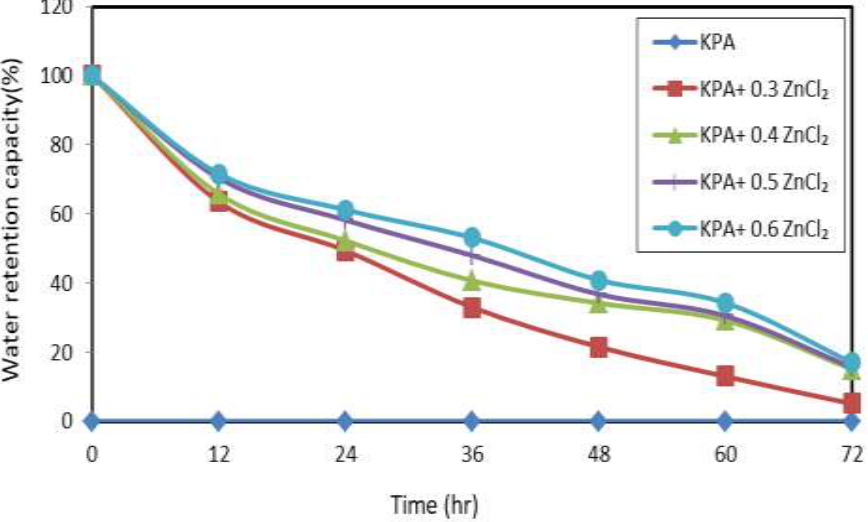
Figure 10 : Water retention capacity (%) of KPA and (Zn-KPA)